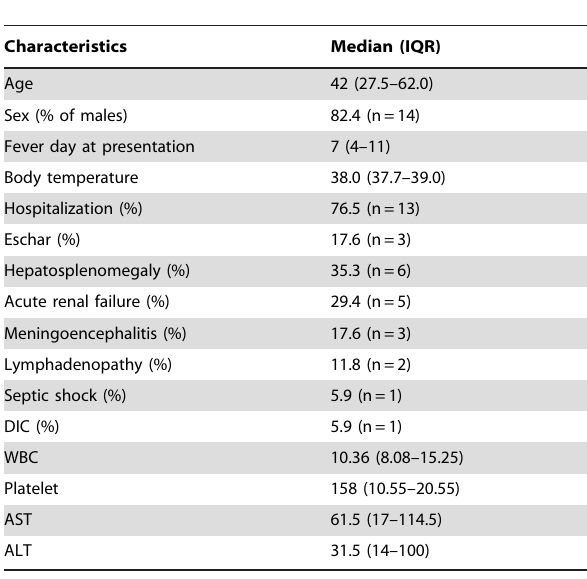
Table 1. Clinical and laboratory characteristics of the patients with scrub